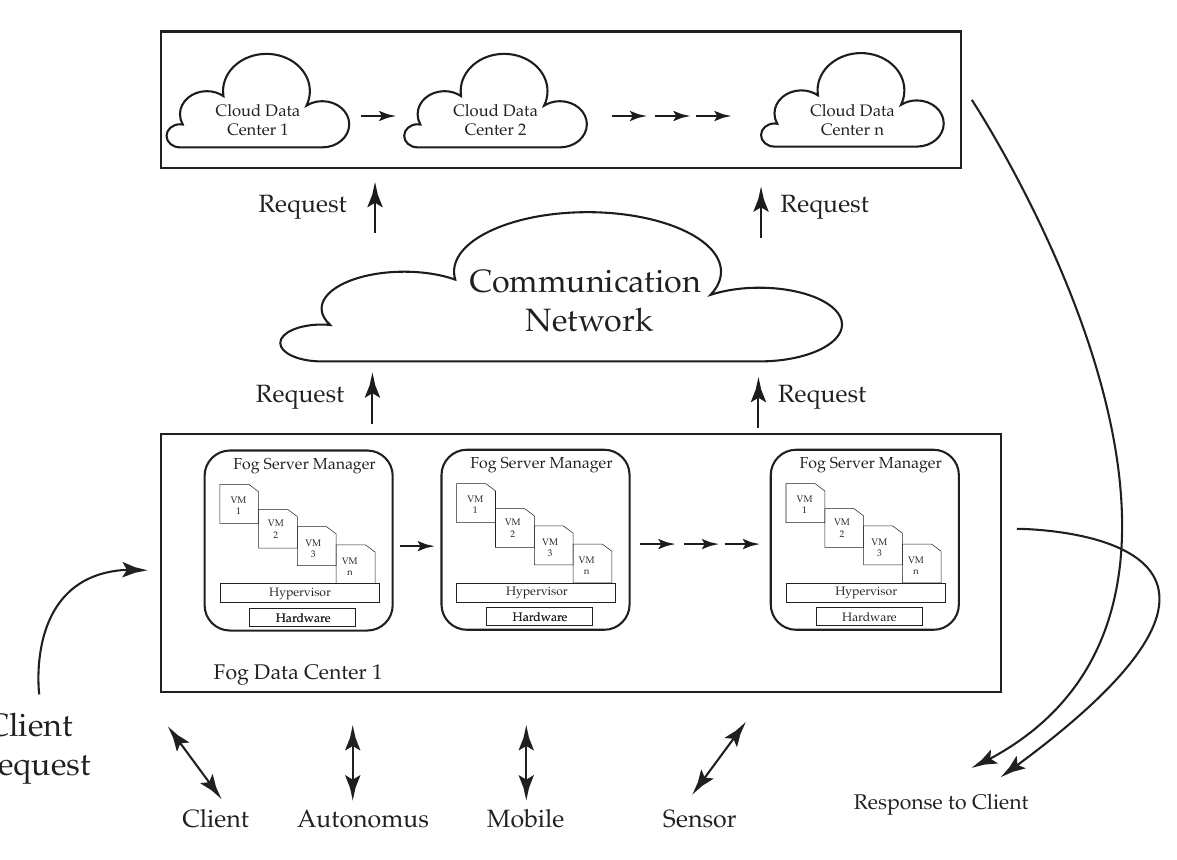
Figure 3. Three-layer architecture